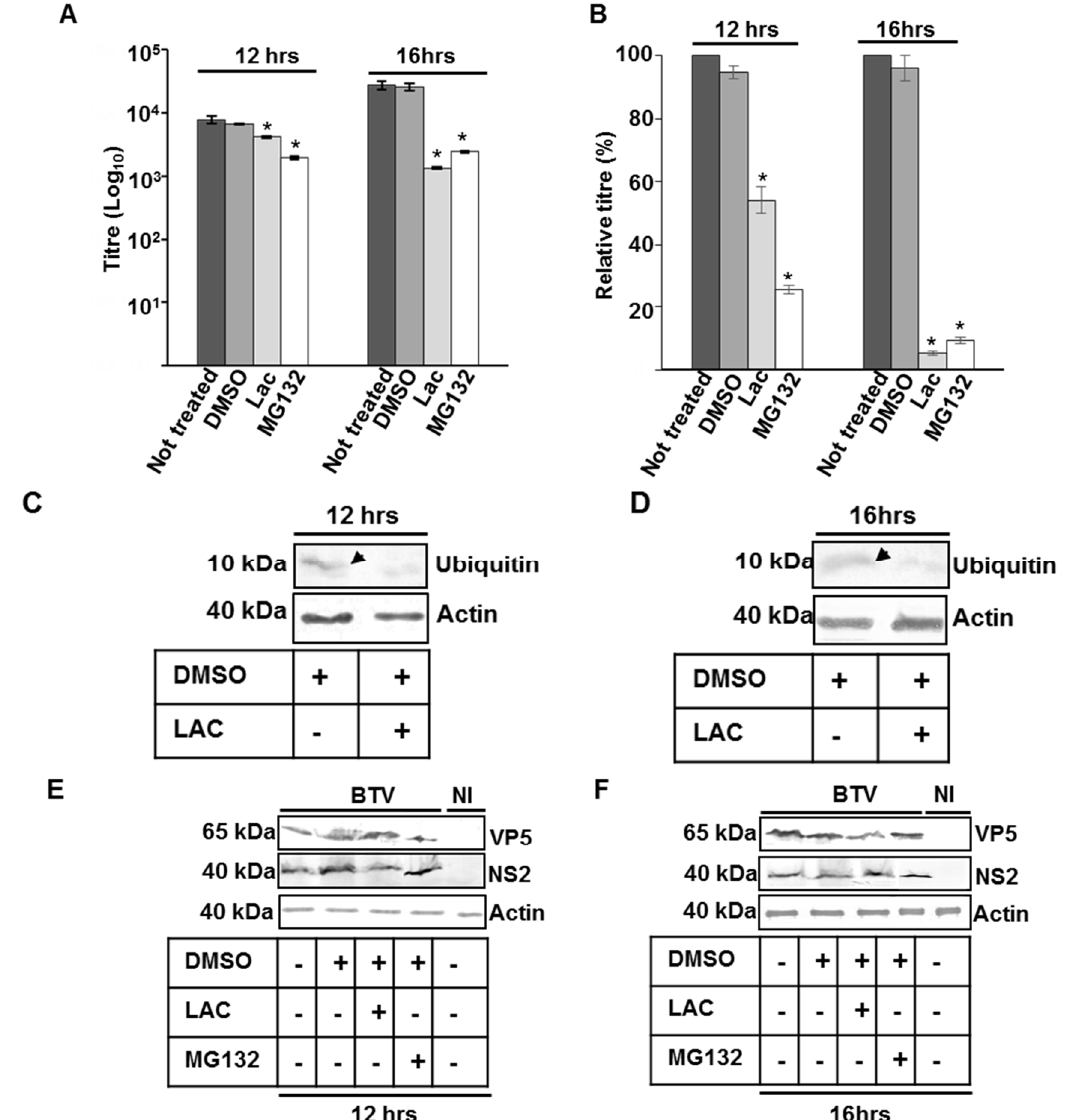
Figure 4. Influence of proteosome inhibitors on virus release. ( A ) PT cells infected with WT BTV at 0.1 MOI were incubated for 10 or 14 h and treated with MG132 or lactacystin for 2 h. Total and released virus titres were assessed by plaque assay and the significant difference in the virus titres were designated by asterisk ( * ). The plaque assays were done in triplicate and bars represent standard error; ( B ) Relative virus titres of ( A ); ( C – F ) Expression of free ubiquitin ( C , D ) and VP5, NS2, actin ( E , F ) in treated and infected PT cells. The cells were treated similar to A , B . Lysates were analyzed by SDS-PAGE and Western blotting. Molecular masses and proteins are indicated on left and right, respectively. Presence or absence of diluent DMSO and inhibitors has been indicated by (+) or ( − ), respectively. Arrows represent presence of ubiquitin in untreated cells. NI signified uninfected